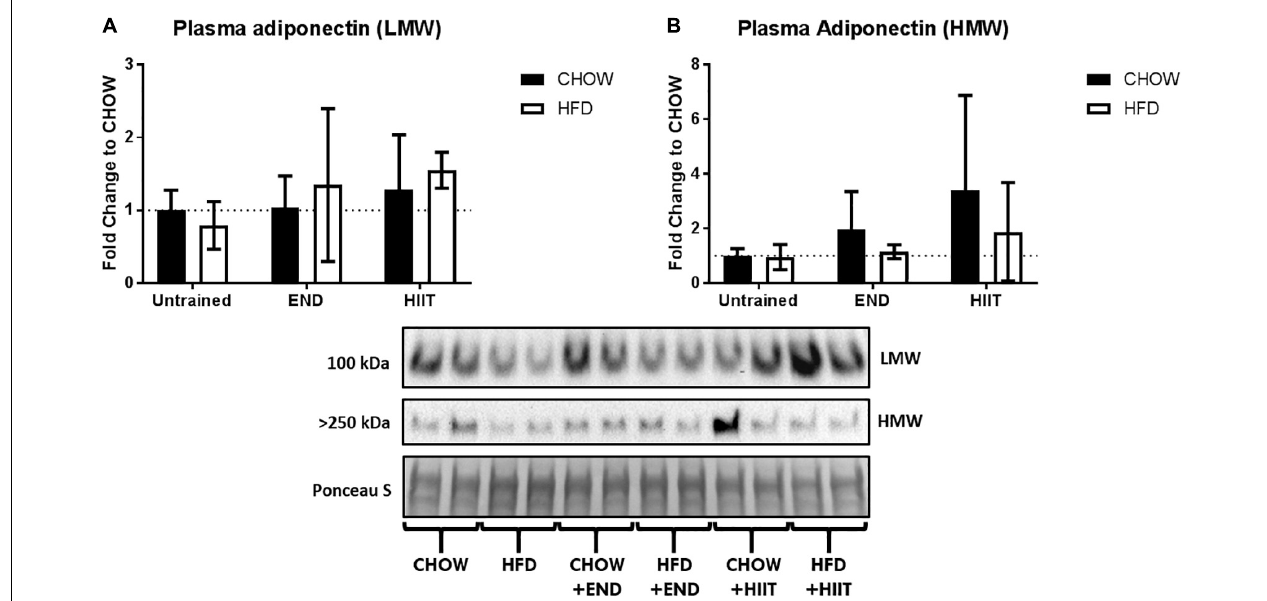
FIGURE 2 | Plasma levels of adiponectin isoforms. (A) Low molecular weight (LMW) and (B) high molecular weight (HMW) adiponectin in plasma. Data are presented as mean ± SD and the number of animals per group is 8. ∗ p < 0.05 vs. CHOW untrained; # p < 0.05 vs. HFD untrained by Two-way ANOVA with Tukey’s and Sidak’s post hoc tests.